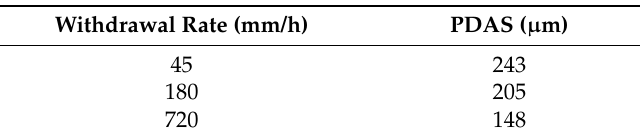
Table 1. Effect of the withdrawal rate on the average primary dendrite arm spacing